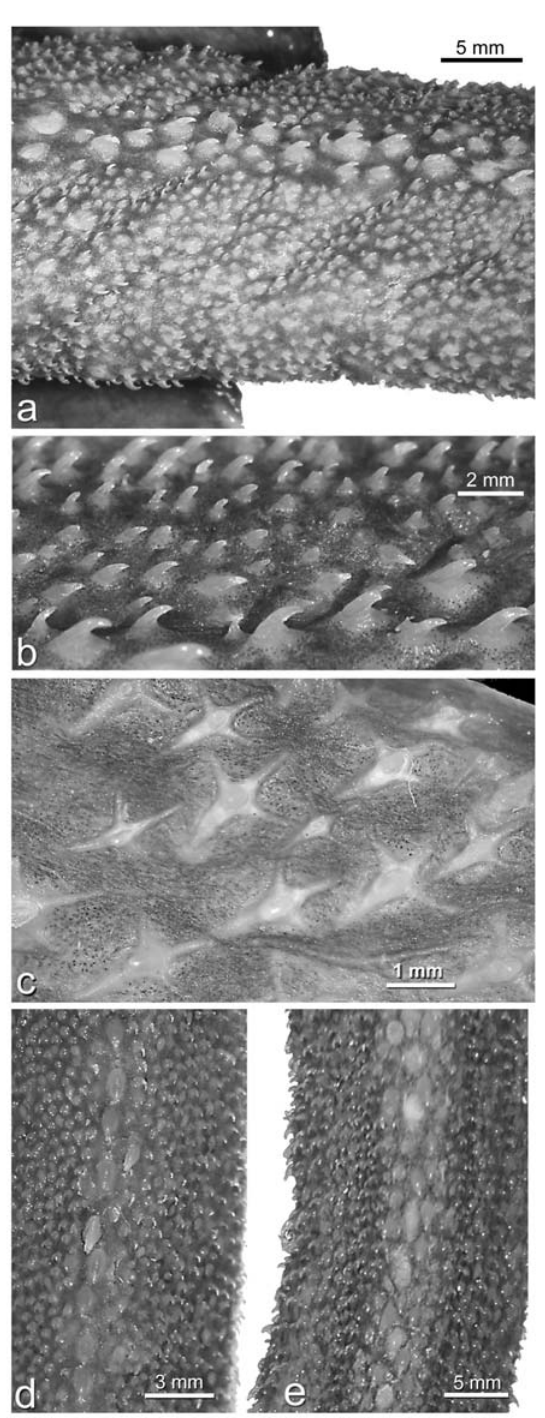
Fig. 7. Dermal denticles and thorns of Malacoraja obscura , n. sp. (a) base of tail region of holotype in lateral/oblique view (MNRJ 28289, 680 mm TL); anterior toward left. (b) close-up of denticles on lateral tail region just dorsal to lateral tail fold of holotype; anterior toward left. (c) denticles from ventral anterolateral snout region of holotype. Note cross-shaped bases; anterior toward right. (d) base of tail in dorsal view of small female (MNRJ 28293, 251 mm TL). (e) dorsal view of tail base of largest male (MNRJ 28290, 505 mm TL). Anterior anterior toward top in (d) and (e).